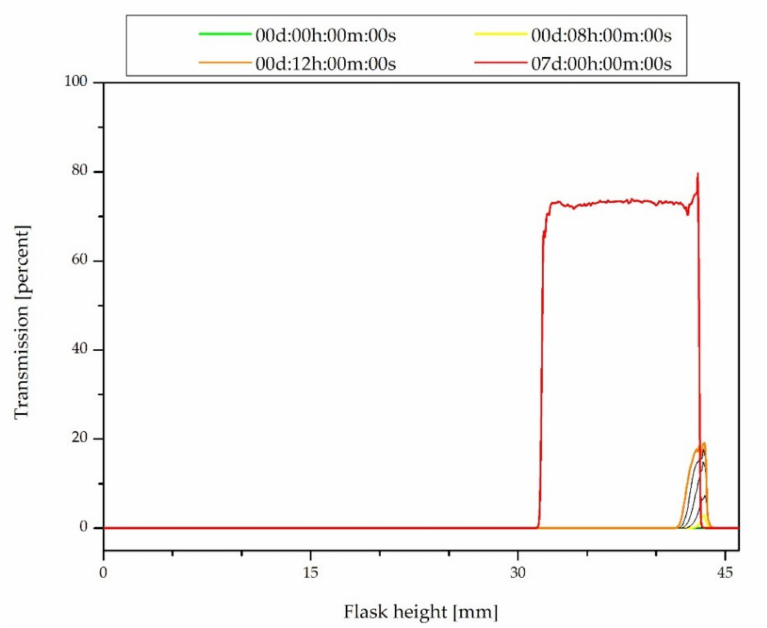
Figure 1. Transmission profiles of the silica–MWCNTs/PDMS hybrid filler suspension just after the synthesis.